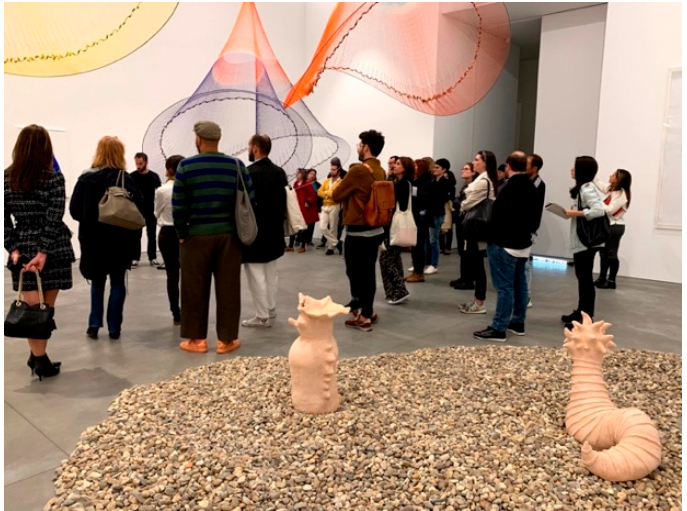
Figure 5. Galeria Francisco Fino, “Serendipity or the Art of Reading the Signs”, 2019. © Galeria Francisco Fino.